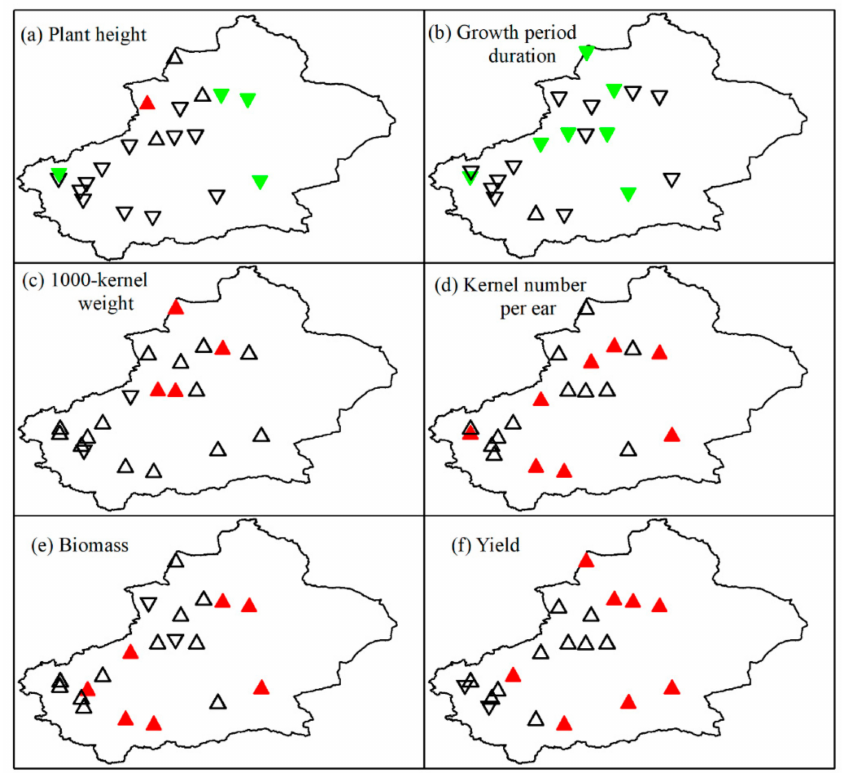
Figure 5. Spatial distributions of the trends and significance of the growth-related and yield- related variables of winter wheat. ( a ) Plant height of maturity stage, ( b ) growth period duration, ( c ) 1000-kernel weight, ( d ) kernel number per ear, ( e ) biomass of maturity period and ( f )